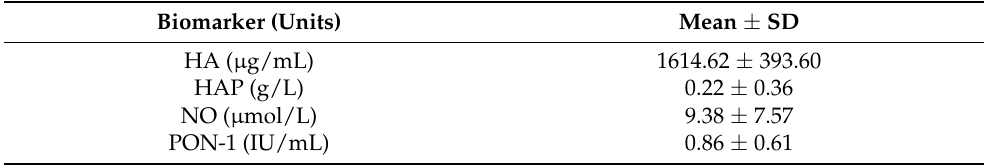
Table 2. Synovial fluid biomarker concentrations at baseline (V 1 ). Values represent synovial concen- tration of biomarkers in the stifle of dogs with cranial cruciate ligament lesion.